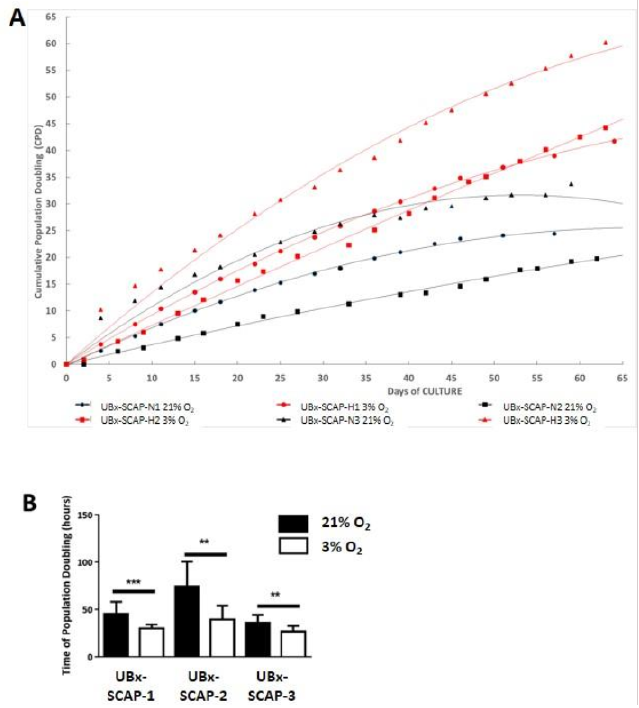
Figure 2. Proliferative advantage of UBx-SCAP isolated under 3% O 2 in comparison with ambient air (21% O 2 ). ( A ) At each passage of SCAPs from EXP III, 0.4 (under 3% O 2 ) or 0.8 (under 21% O 2 ) millions of cells were seeded in a 75 cm 2 flask and counted after three or four days. Cumulative population doublings (CPD) were plotted for each individual refered to UBx-SCAP-N1, N2 and N3 (21% O 2 ) and UBx-SCAP-H1, H2 and H3 (3% O 2 ), up to 65 days. ( B ) The mean of time of population doubling for the first 10 passages, for each individual at 21% and 3% O 2 is plotted with standard deviation. Statistical analyses were done with a Mann-Whitney test. ** p < 0.01. *** p <